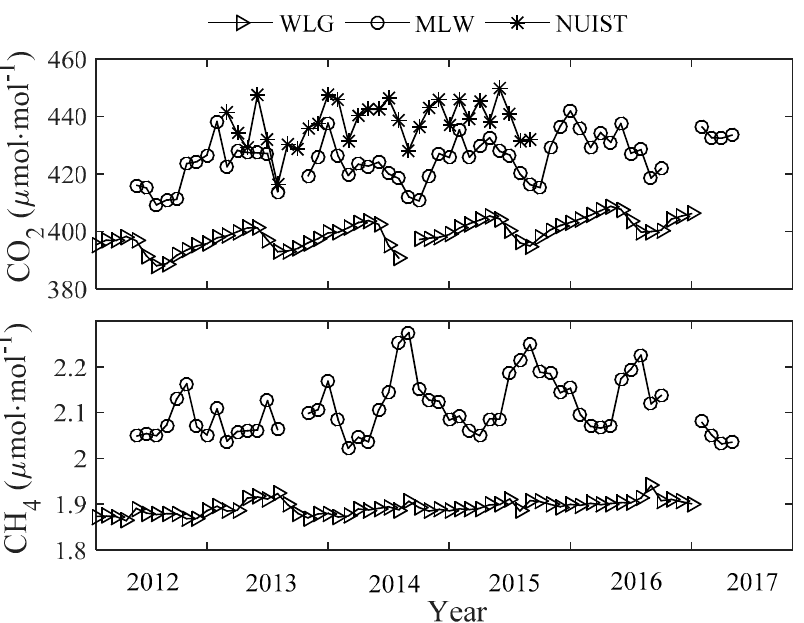
Figure 6. Variations of monthly molar fraction of CO 2 in the atmosphere at Nanjing University of Information Science and Technology (NUIST), WLG and MLW and monthly molar fraction of CH 4 at WLG and MLW from 2012 to 2017.